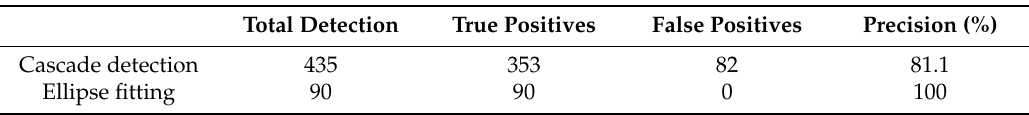
Table 3. Fruit detection using cascade fruit detection and cascade detection followed by ellipse fitting methods for validation set images.